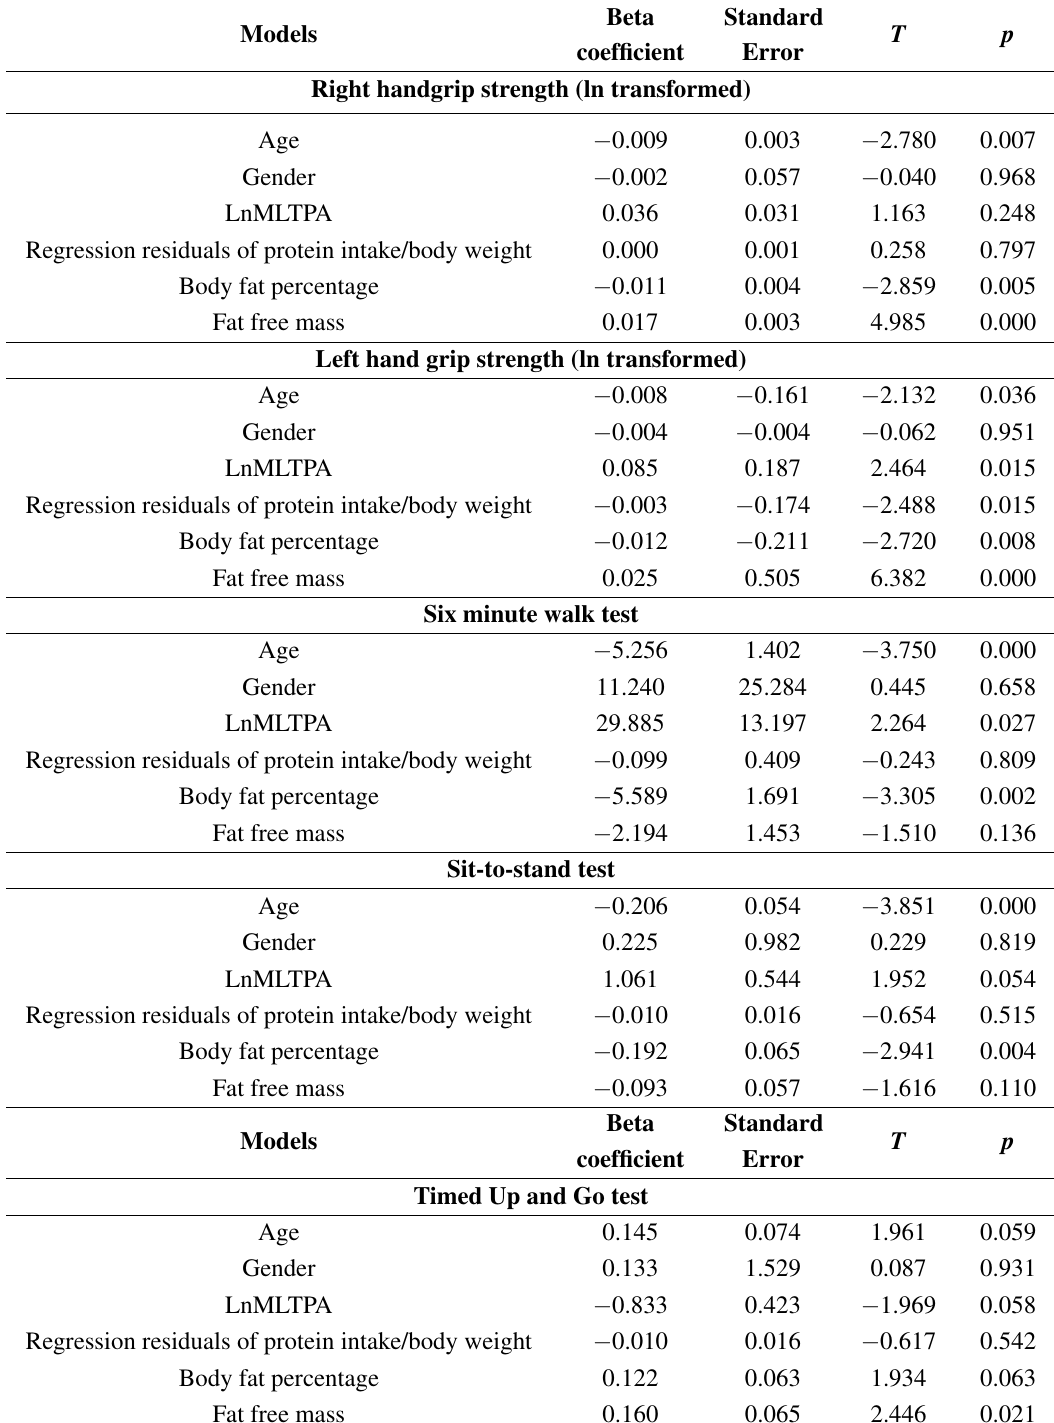
Table 3. Multivariate mixed effects regression models for strength and physical function